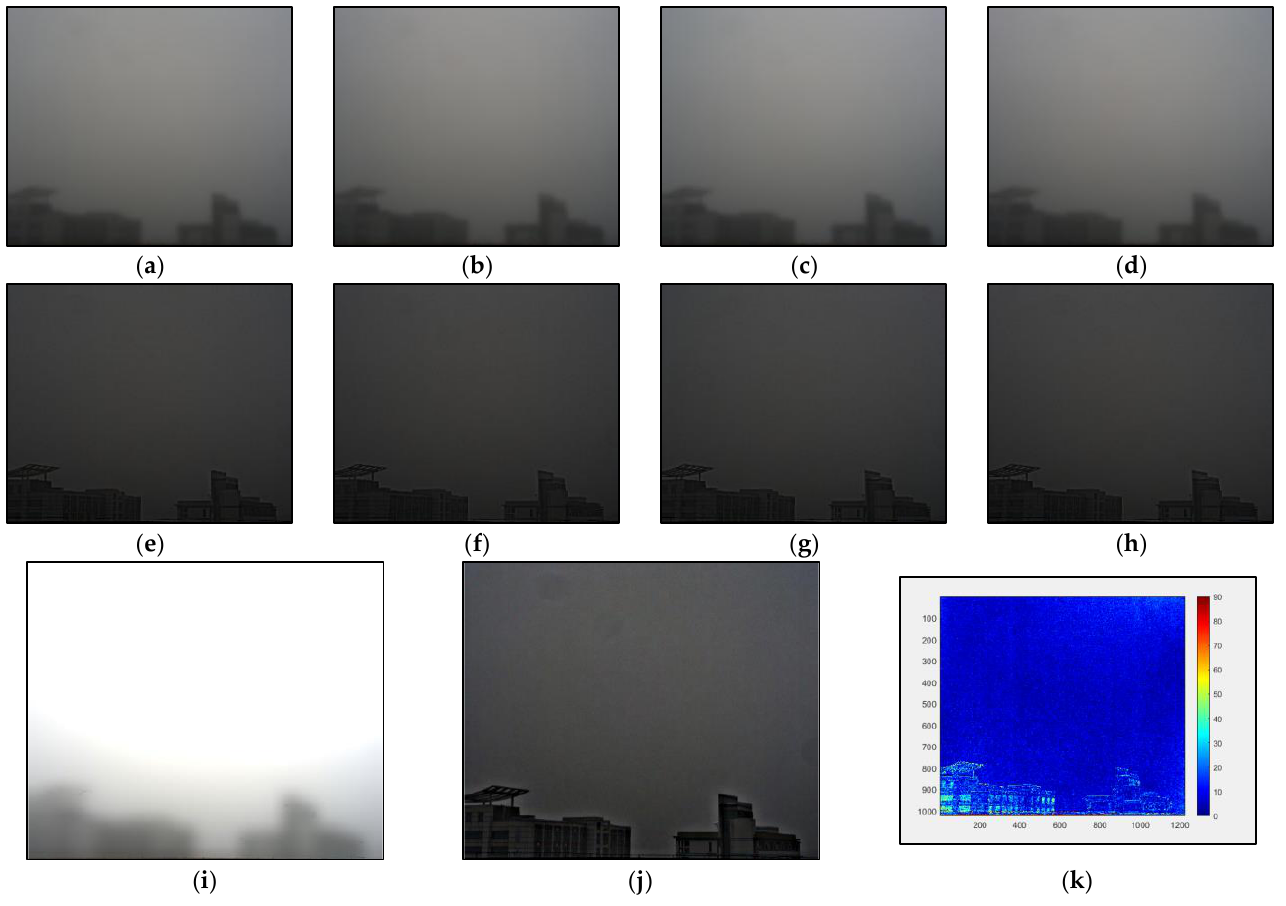
Figure 3. Result of the Gaussian blur filtering, ( a – d ) the polarized air-light images at fours angle, ( e – h ) the polarized object images at fours angles, ( i ) the light intensity of the air-light, ( j ) the light intensity of the object, ( k ) DOP of the object.